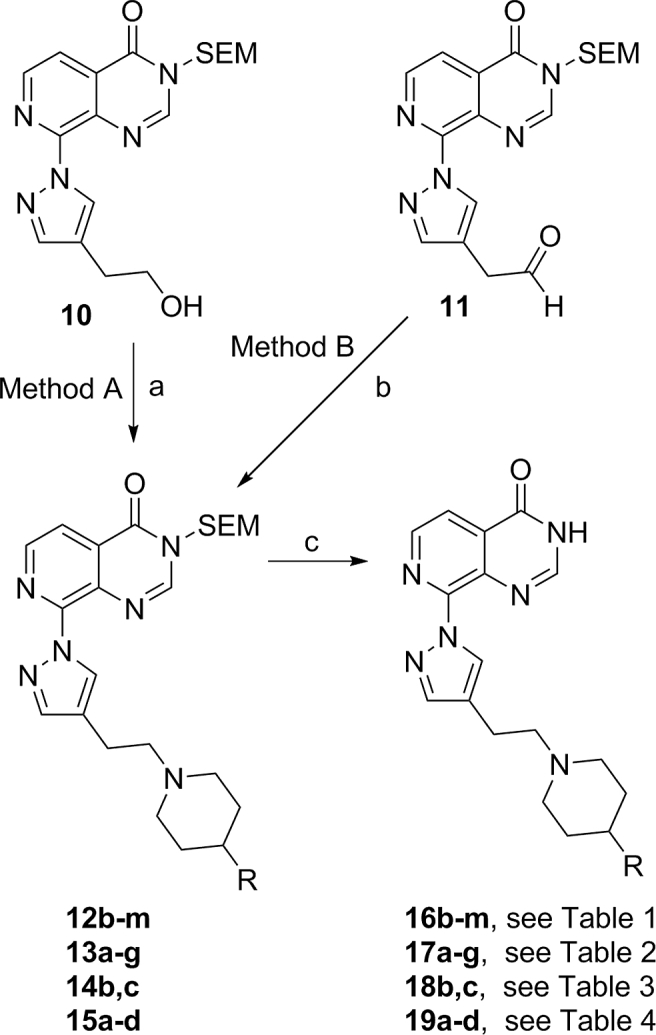
aReagents and conditions: (a) (i) methanesulfonic anhydride, anhydrous CH2Cl2, 0 °C, 15 min, work-up, (ii) triethylamine, C4-substituted piperidine, anhydrous DMF, 50 °C, 15 h; (b) C4-substituted piperidine, anhydrous 1,2-dichloroethane or CH2Cl2, NaBH(OAc)3, room temp.; (c) 6 M HCl, THF, 50–60 °C, 3–8 h or 4 M HCl in dioxane, H2O, 50 °C.